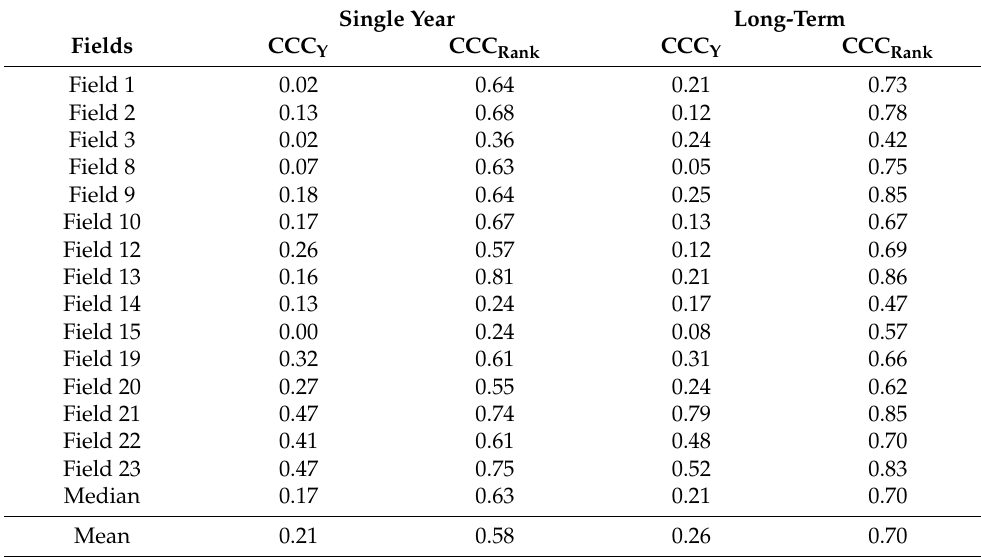
Table 5. CCC values from single-year analysis (median of CCC values from individual years) and multi-year results